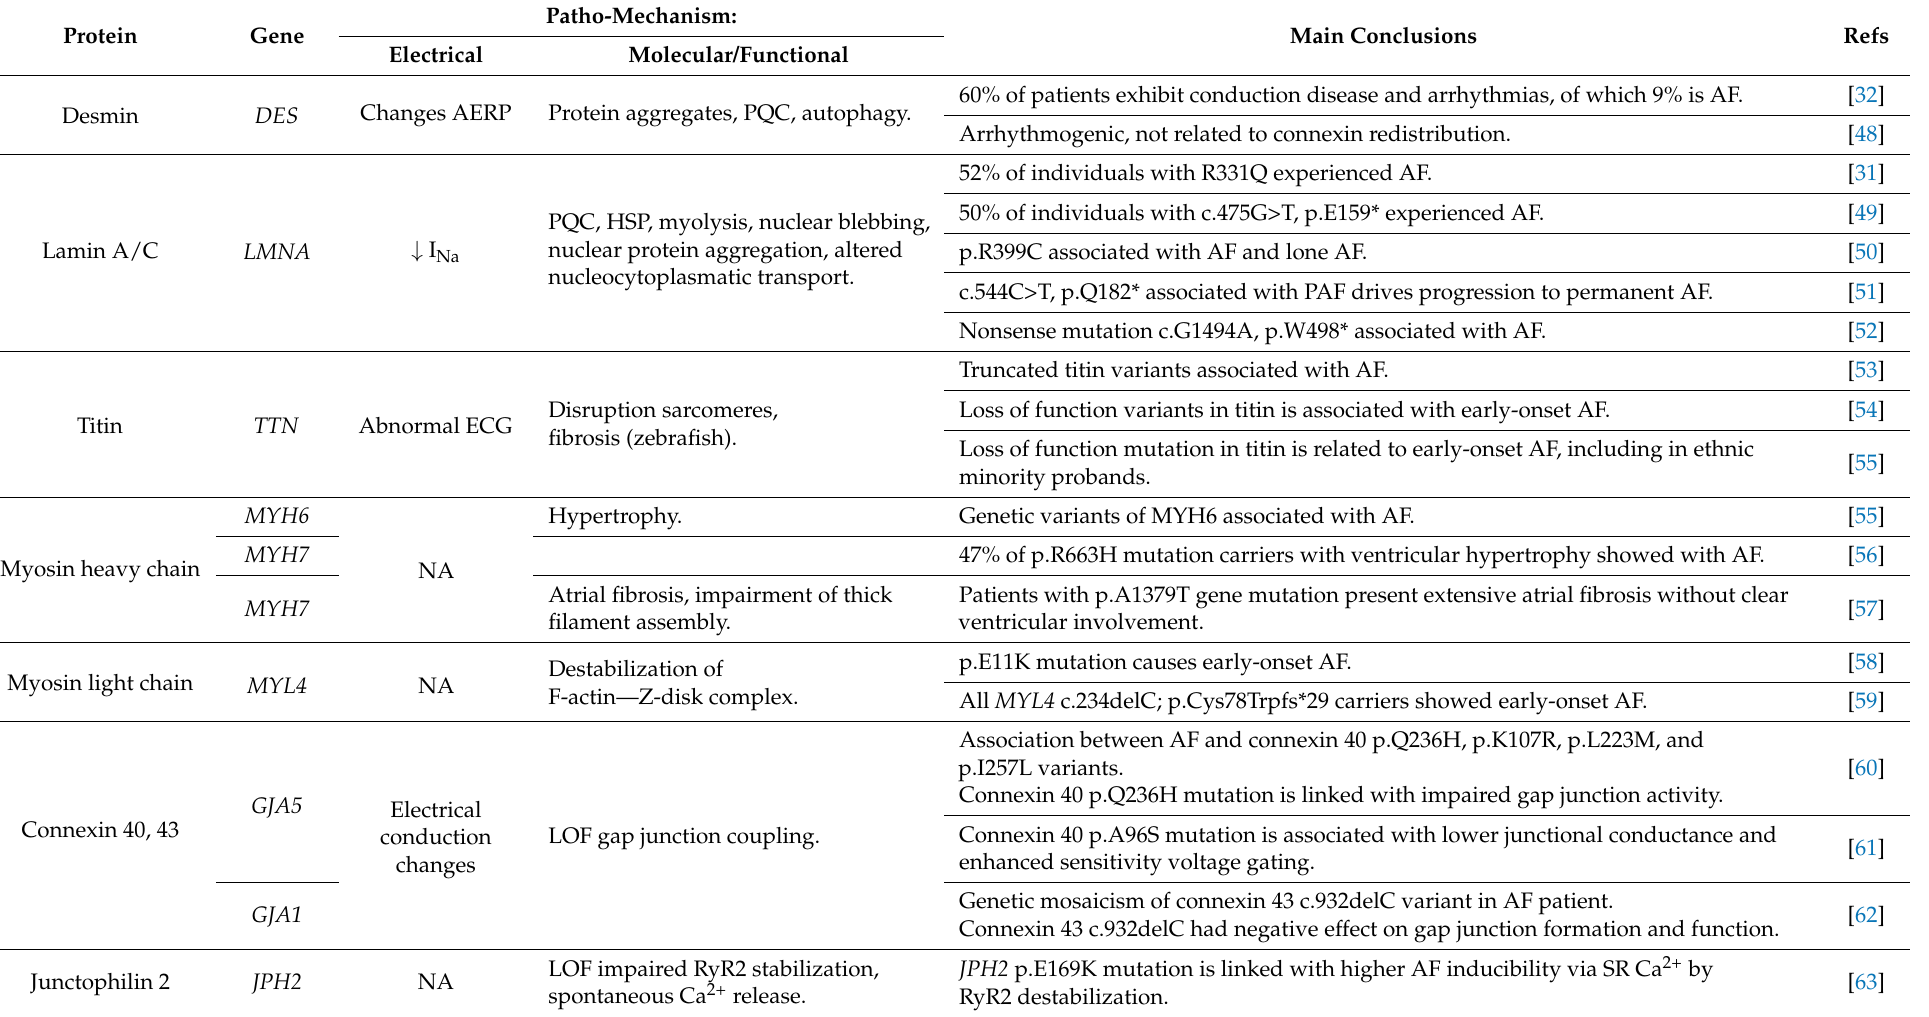
Table 1. Overview of cytoskeletal (-associated) protein variants, identified with whole genome sequencing, that relate to genetic